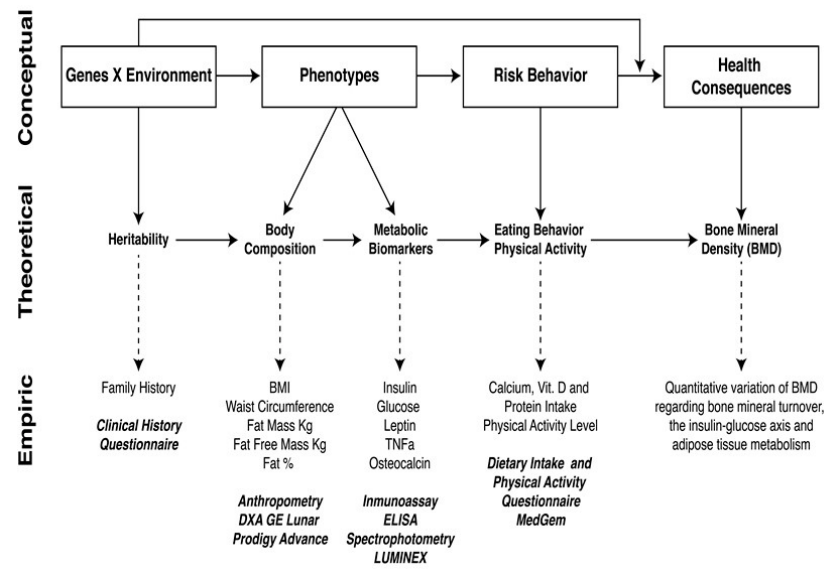
Figure 4. Predictive model of the conceptual-theoretical-empirical GxE influences on BMD and susceptibility to osteoporosis risk within the context of the insulin-glucose axis, and adipose tissue metabolism [31,32].